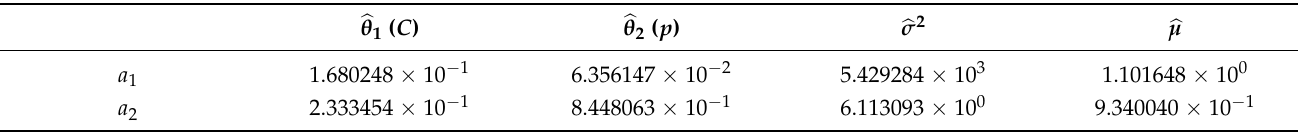
Table 2. Optimal estimates of Kriging model